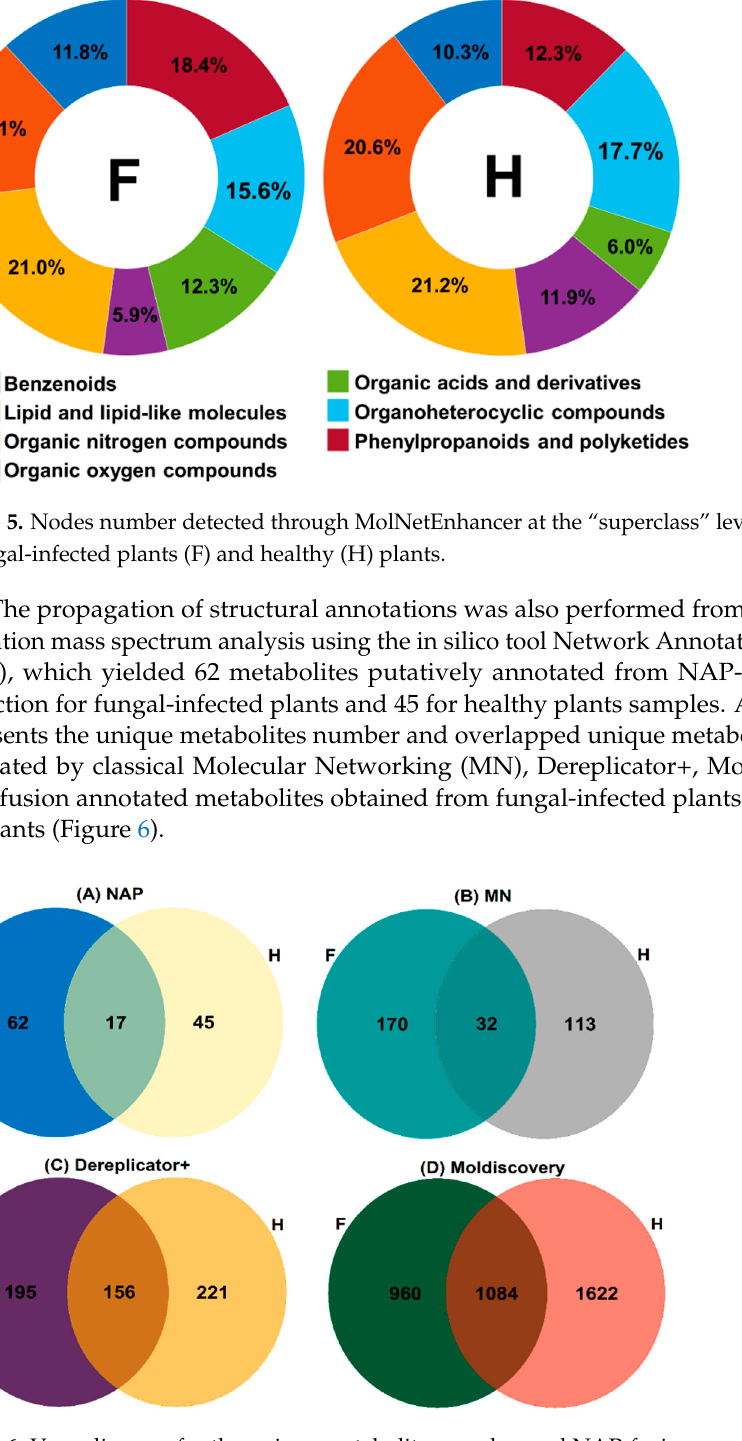
Figure 6. Venn diagram for the unique metabolites number and NAP-fusion annotated obtained of the workflows classical Molecular Networking (MN), Dereplicator+, Moldiscovery, and NAP from fungal-infected plants (F) and healthy (H) plants.